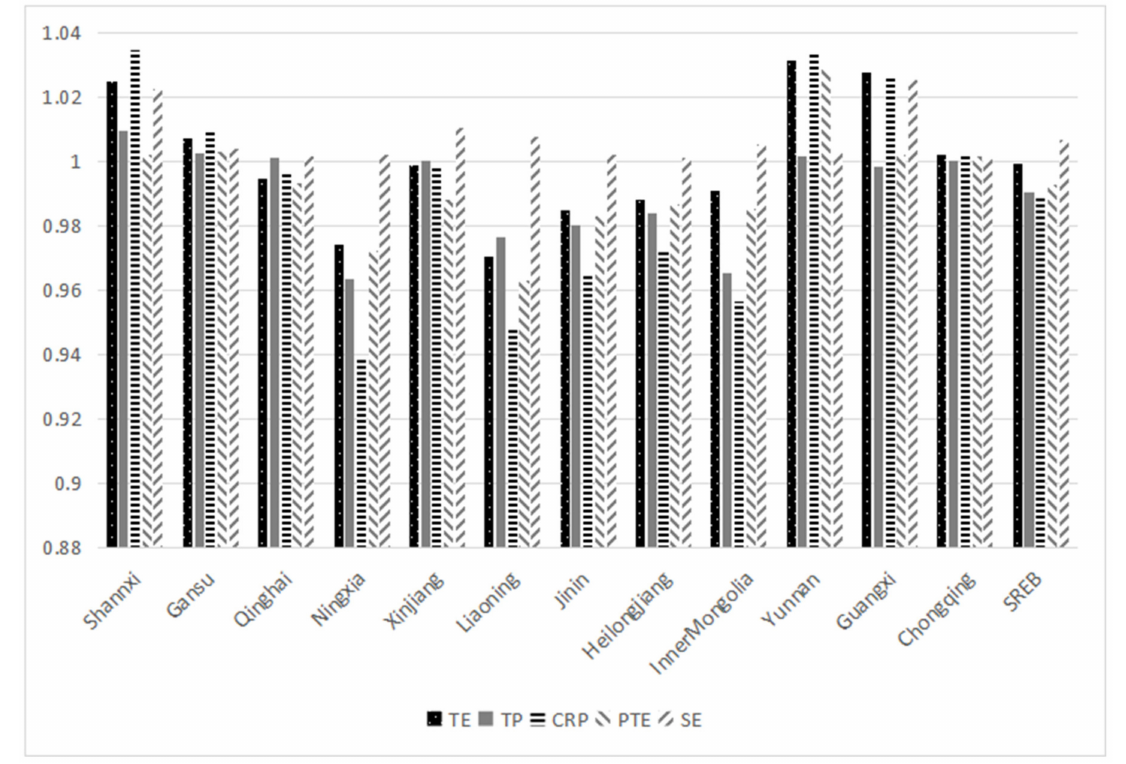
Figure 6. Provincial comparisons of CRP, TE, TP, PTE, and